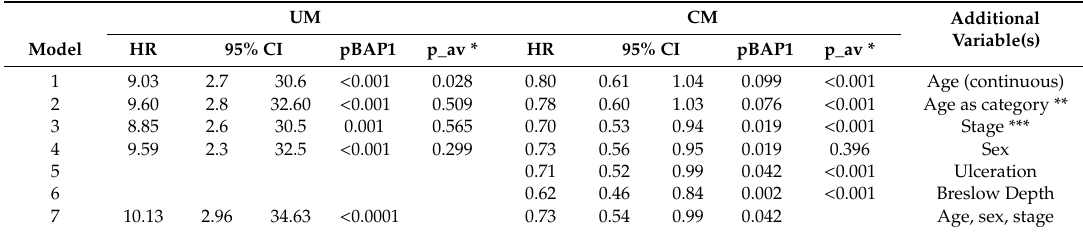
Table 2. Multivariate Cox models to predict BAP1 mRNA levels in UM and CM overall